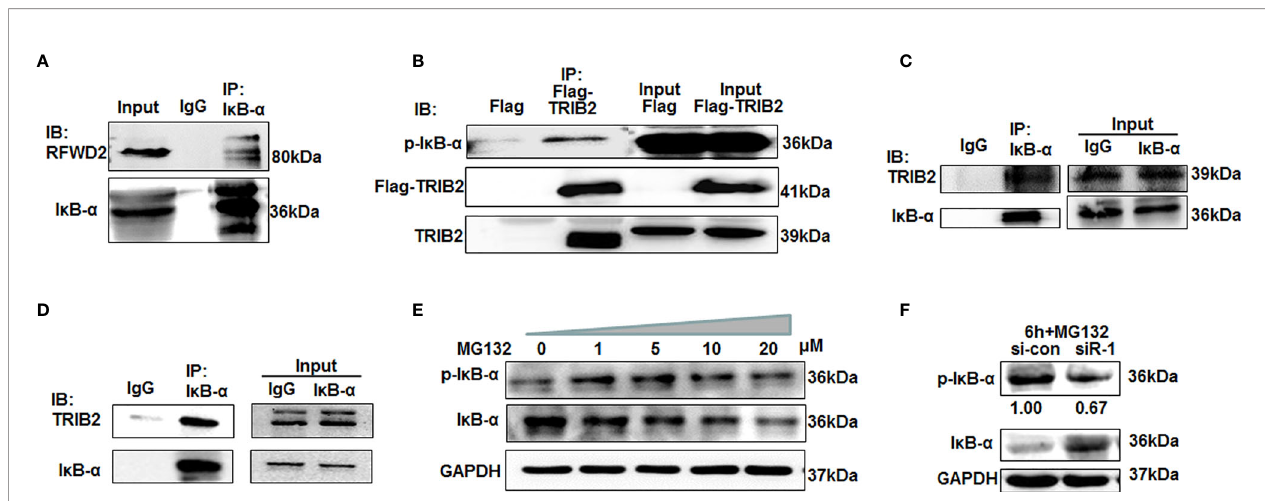
FIGURE 3 | TRIB2 with RFWD2 attend proteasome-mediated p-I k B- a degradation. (A) Coimmunoprecipitation with IKB- a antibodies showing interaction between RFWD2 and I k B- a in 293T cells. (B) Coimmunoprecipitation experiments were carried out using total lysates of 293T cells overexpressing Flag and Flag-TRIB2. M2 af fi nity gel precipitated TRIB2 together with p-I k B- a . (C) Coimmunoprecipitation using 293T lysate and anti-I k B- a antibodies. TRIB2 and I k B- a precipitated together. (D) Expressed and puri fi ed eukaryotic TRIB2 and I k B- a proteins used for coimmunoprecipitation experiments to further study the interaction between I k B- a and TRIB2. (E) p-I k B- a and I k B- a expression detected by Western blotting in A549 cells following treatment with various concentrations of MG132. (F) A549 cells were treated with 20 m M MG132 for 6 h following TRIB2 knockdown with siRNA and the total lysate was subjected to Western blotting to detect p-I k B- a and I k B- a expression